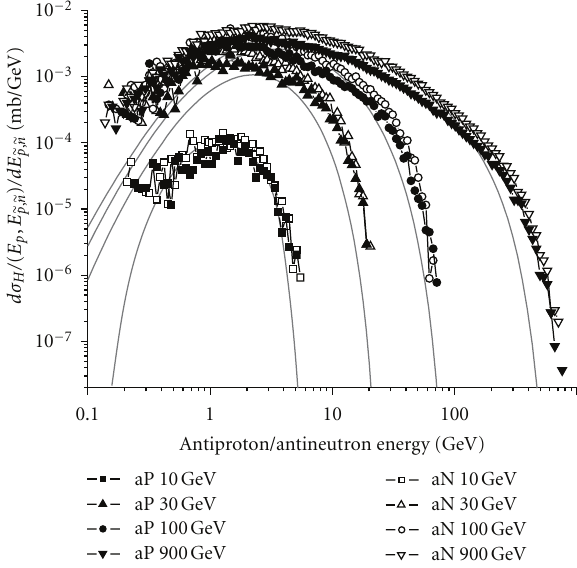
Figure 1: Antiproton (aP) and antineutron (aN) di ff erential cross sections for ( p , H ) reaction. Symbols mark the MSDM results; thick solid lines represent the Tan and Ng [12] approximation.